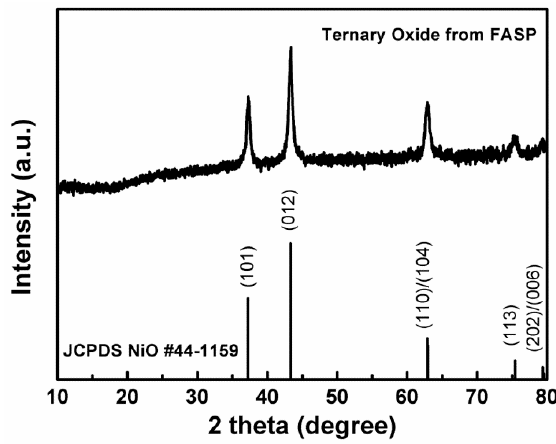
Figure 5. XRD patterns of ternary metal oxides obtained from flame-assisted spray pyrolysis using 1 M precursor solution.